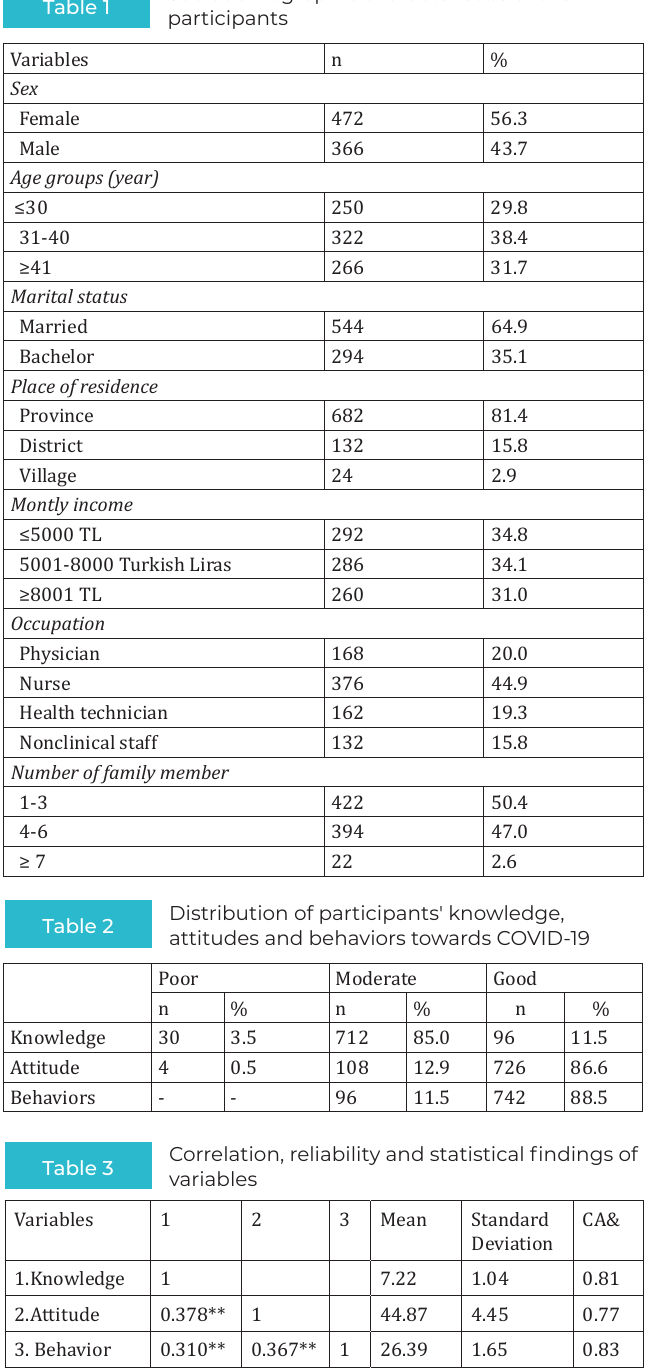
Sociodemographic characteristics of the participants